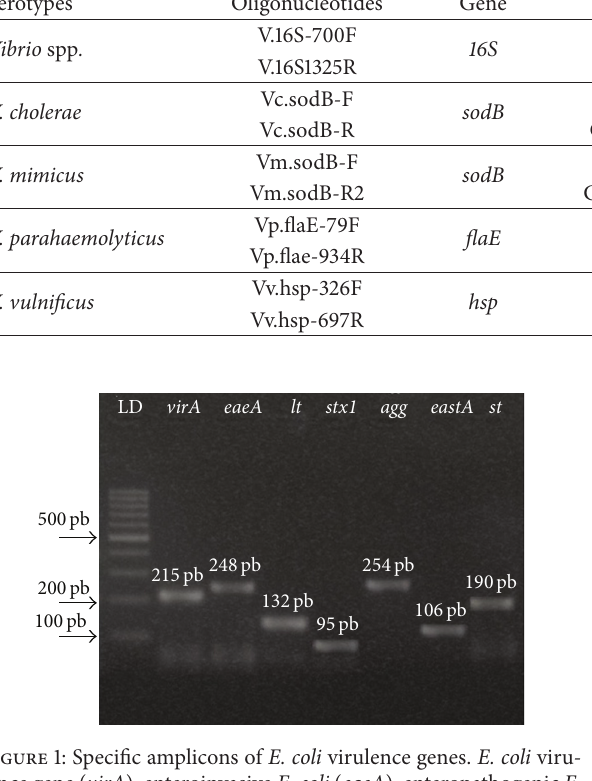
Table 2: Oligonucleotide sequences used for the identification of the Vibrio genus and serotypes. Serotypes